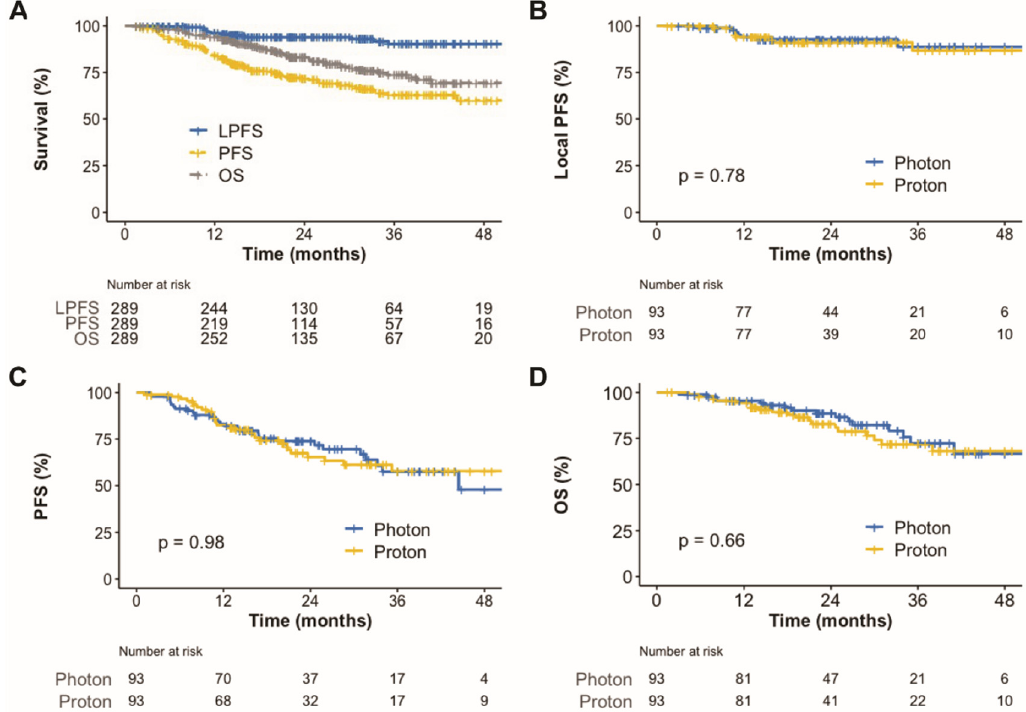
Figure 1. Kaplan–Meier plot of local progression-free survival, progression-free survival, and overall survival rates for all patients over 48 months ( A ). Kaplan–Meier plot of local progression-free survival ( B ), progression-free survival ( C ), and overall survival rates ( D ) for matched patients according to radiotherapy techniques over 48 months. PFS, progression-free survival; OS, overall survival. (versus central), and BED 10 ≥ 125 CGE were associated with improved local control.